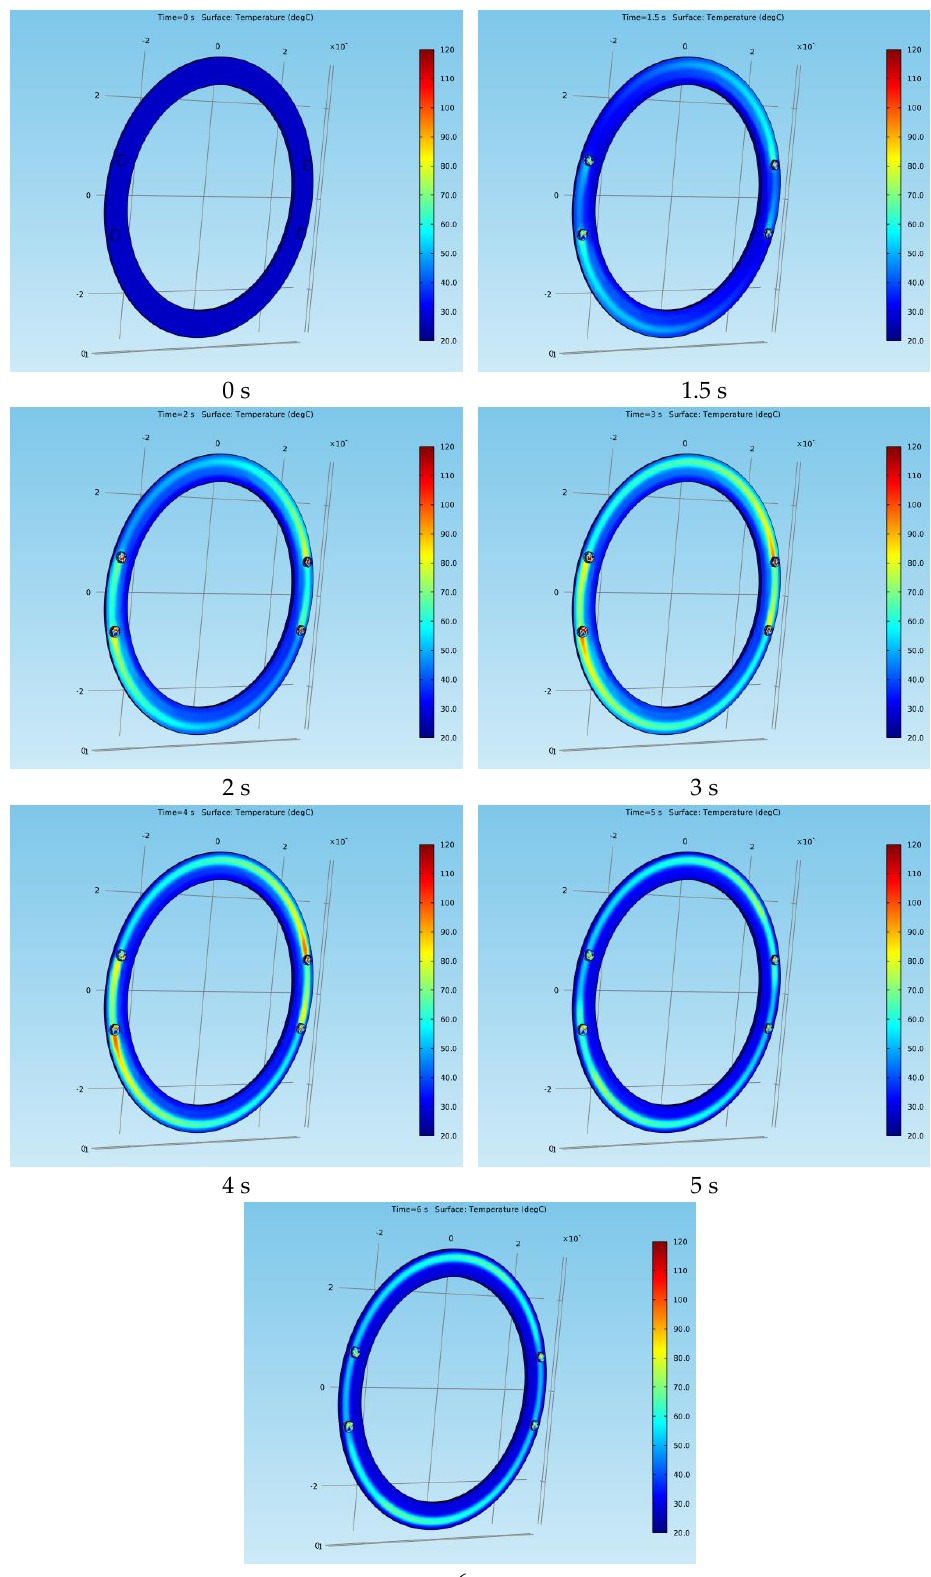
Figure 20. Surface temperature variation in position for the drum-and-shoe brake system.